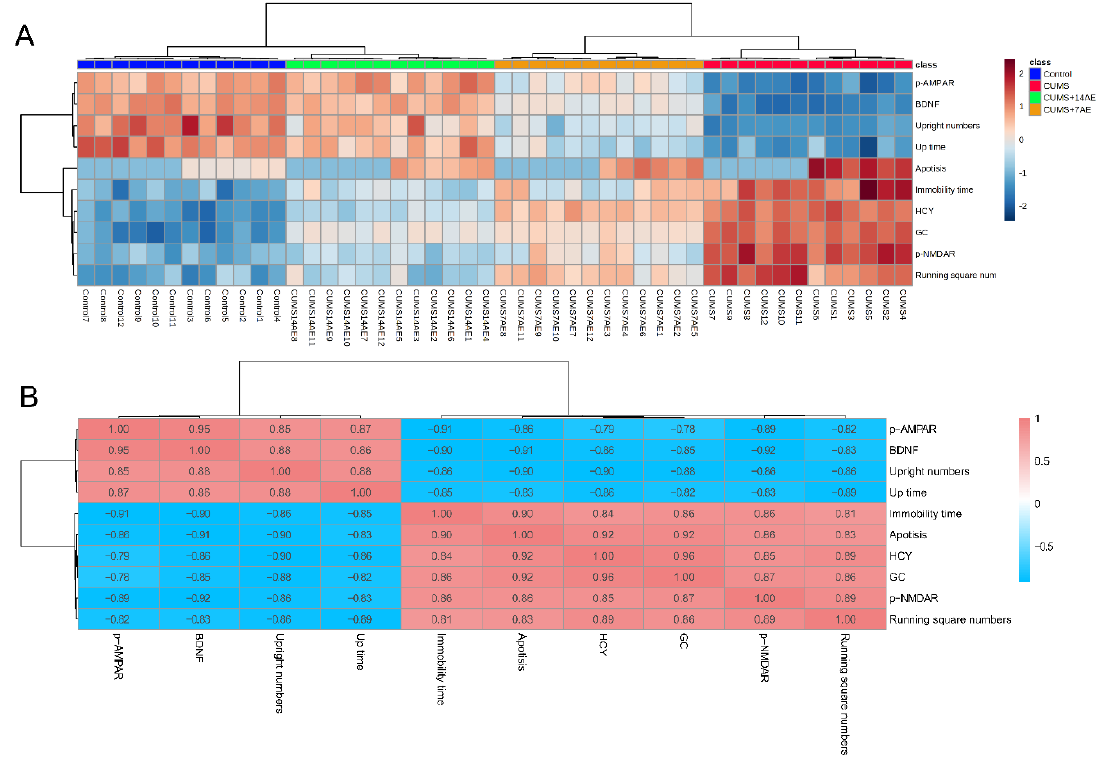
Figure 6. Clusters derived from behavioral indices and molecular alterations discriminating groups ( A ). Correlations between behavioral indices assessed by the open field test and forced swimming test, expression of iGluRs, i.e., phosphorylation of AMPA receptor and phosphorylation of NMDA receptor, brain-derived neurotrophic factor (BDNF), homocysteine (HCY) in hippocampus as well as serum glucocorticoids (GC) ( B ). CUMS: chronic unpredictable mild stress; 7AE: Aerobic exercise for 7 days; 14AE: Aerobic exercise for 14 days.